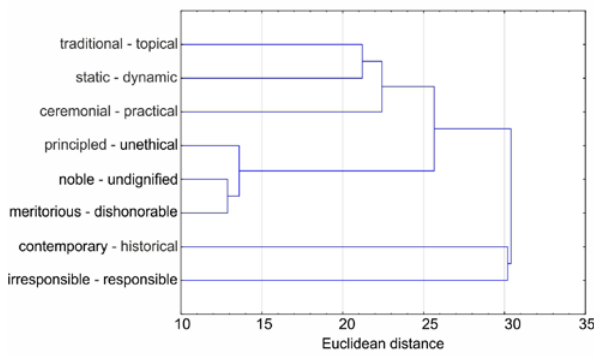
Figure 2: Dendrogram with 8 selected items for both men and women, measured by Euclidean